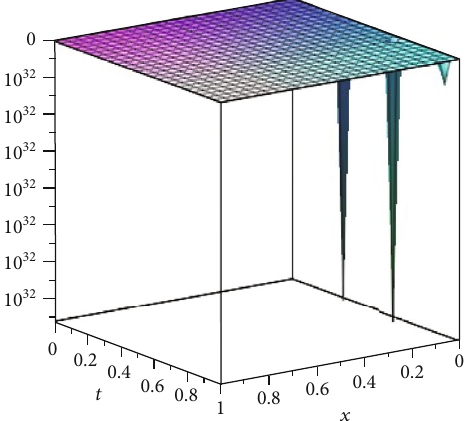
ð x , t Þ of Equation 2,1